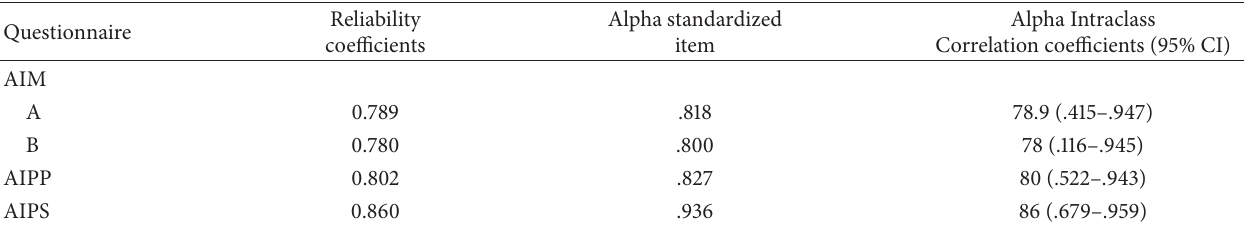
Table 3: Reliability results for Abuja Instrument for Midwives (AIM), Abuja Instrument for Parturient Pain (AIPP), and Abuja Instrument for Parturient Spouses (AIPS).